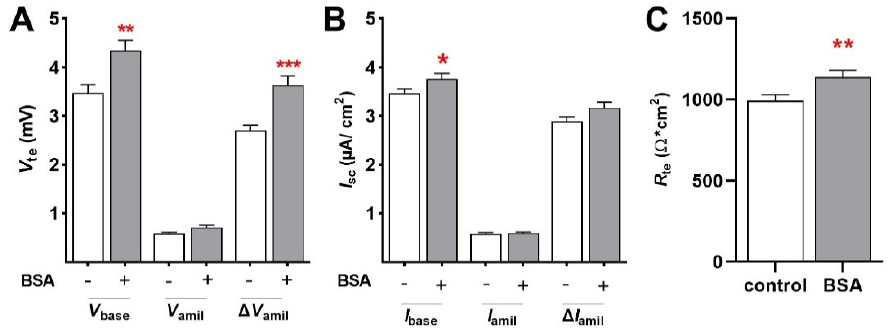
Figure 4. BSA increases epithelial Na + transport after 45 min. FDLE cells were cultured in MEM and stimulated with BSA (1.0 g/L) for 45 min. Data are displayed as mean + SEM. BSA significantly increased ( A ) V base , Δ V amil , and ( B ) I base (n = 67–69; * p < 0.05; ** p < 0.01; *** p < 0.001 by t -test). ( C ) BSA further significantly elevated R te in FDLE cells after 45 min (** p < 0.01 by t -test).